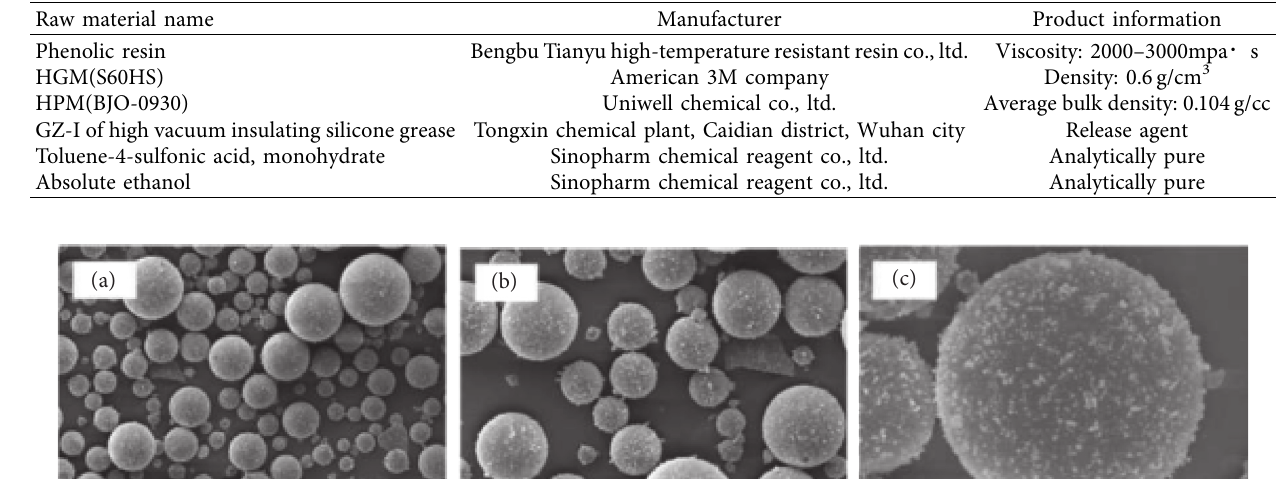
Table 1: The main raw materials and reagents of the